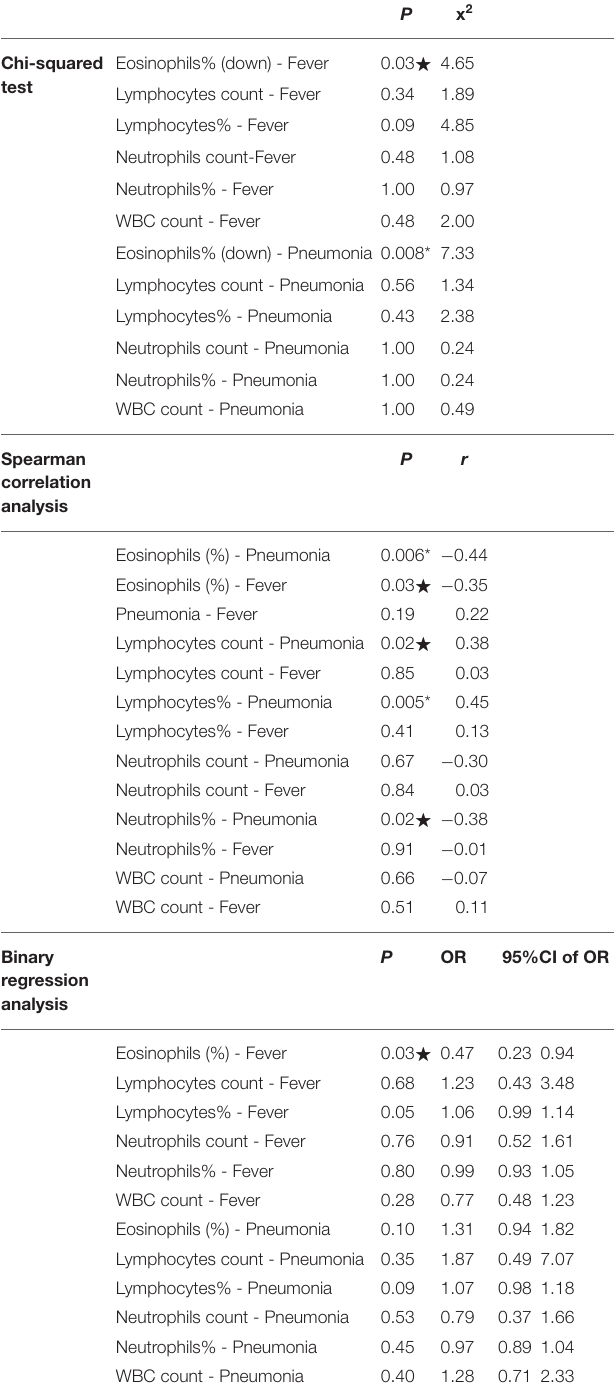
TABLE 2 | The correlative analysis of eosinophils percentage, fever, and pneumonia.